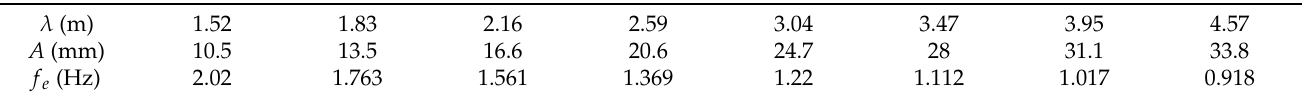
( b ) Figure 6. Comparison of numerical and experimental results of heave and pitch motion transfer functions 𝑇𝐹 𝑥3 and 𝑇𝐹 𝑥5 for different encounter frequencies 𝑓 𝑒 . ( a ) 𝑇𝐹 𝑥3 . ( b ) 𝑇𝐹 𝑥5 .